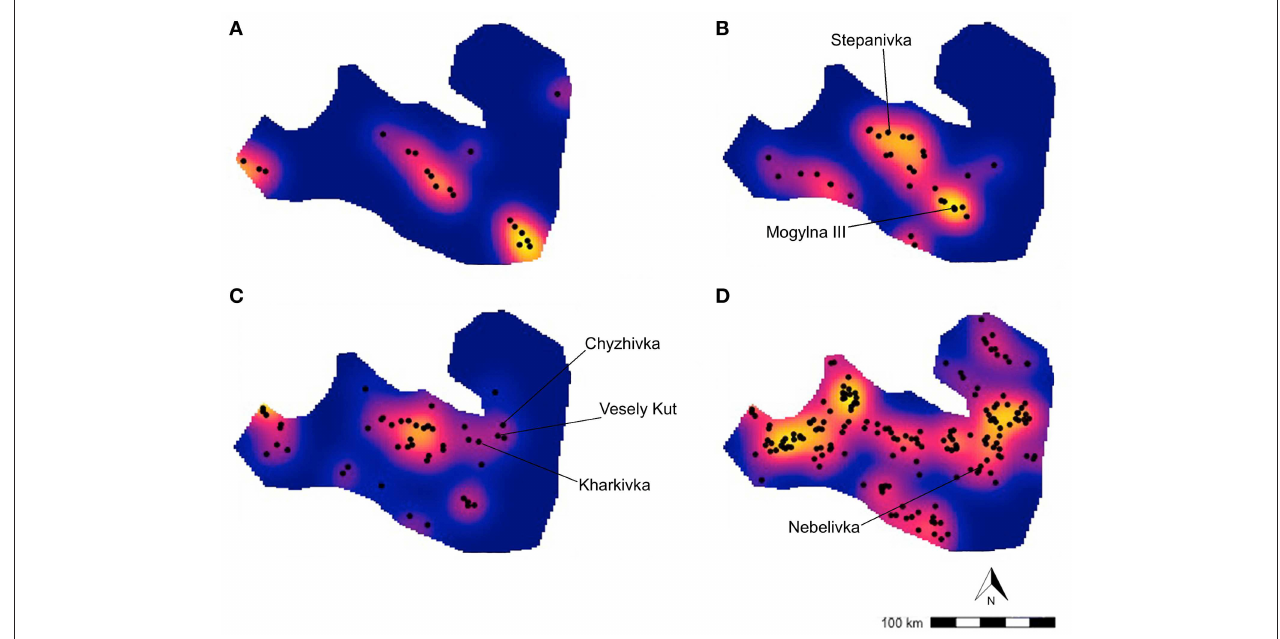
FIGURE 5 | Kernel density surface of the sites in the three phases considered, Forest Neolithic (A) , Trypillia A (B) , Trypillia BI (C) , Trypillia BII (D) . Gaussian kernel, σ = 20km. Blue - yellow colours are low to high densities in quantile breaks. Overlaid are the actual sites as black dots. The main sites mentioned in the text are highlighted with